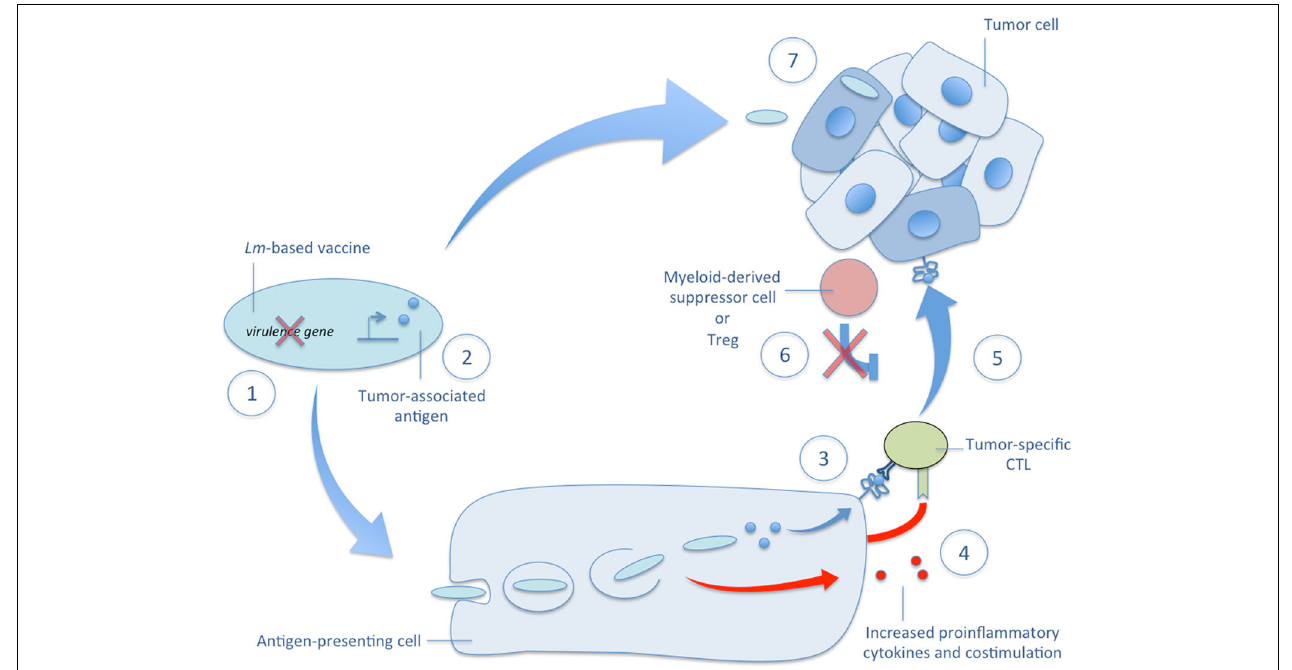
FIGURE 2 | Mechanisms of Lm -based vectors in tumor immunotherapy. Several mechanisms governing the efficacy of Lm -based immunotherapies are depicted in the accompanying figure. (1) There are several very effective methods of attenuation available to construct a highly immunogenic Lm -based vector usually involving deletion of one or more virulence genes. (2) Once attenuated, Lm -based vectors are highly versatile producers of tumor-associated antigens and other therapeutic proteins. (3) After administration, Lm -based vaccines selectively infect antigen-presenting cells, escape the phagosome, and secrete tumor-associated antigens that are delivered to a high-efficiency processing and presentation pathway for activation of tumor-specific CTLs. (4) The detection of Lm -derived PAMPs facilitates tumor-specific CTL activation through the upregulation of